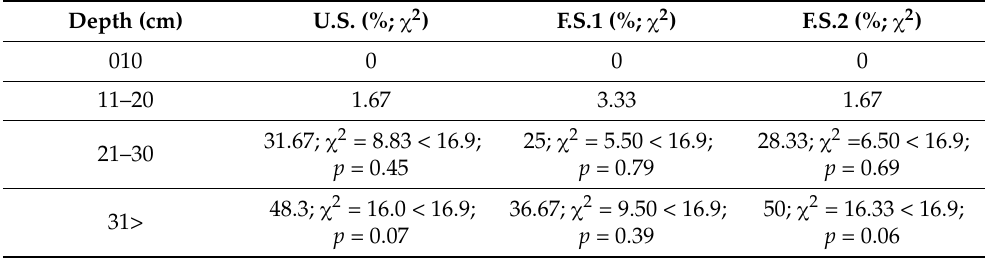
Table 9. Percentage share of measurements that did not reach the set depth interval of penetration resistance measurements and the X 2 test for the measurements where the depth interval was not